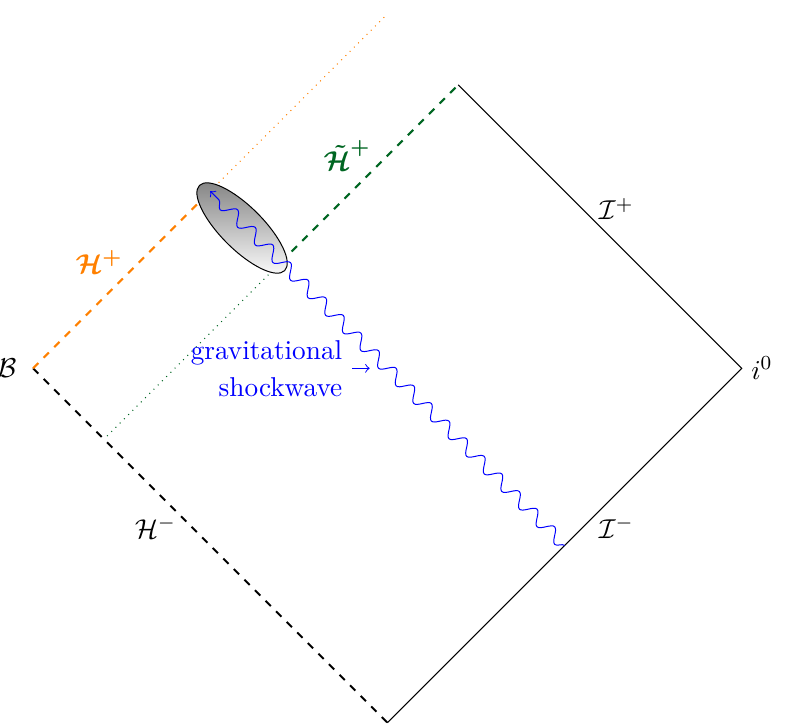
Figure 3 . Penrose diagram for shockwave entering black hole. Shaded oval denotes absorption (not in solution space). Dashed orange (green) line is initial (final) horizon H + ( ˜ H +